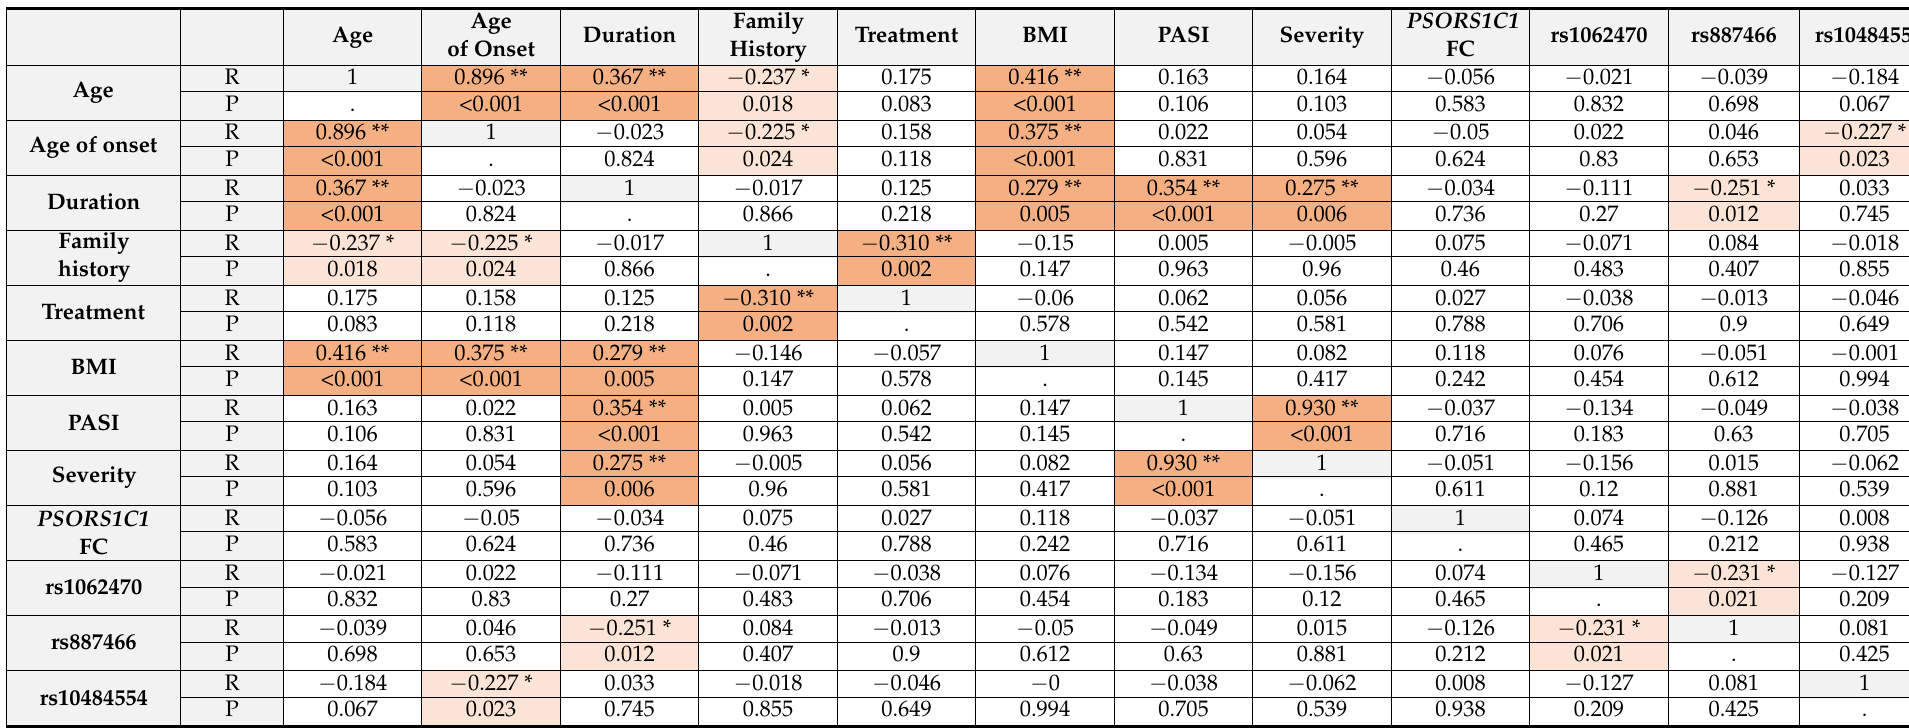
Table 6. Correlation matrix showing the inter-relationships among the studied SNPs, PSORS1C1 gene expression, and clinicopathological